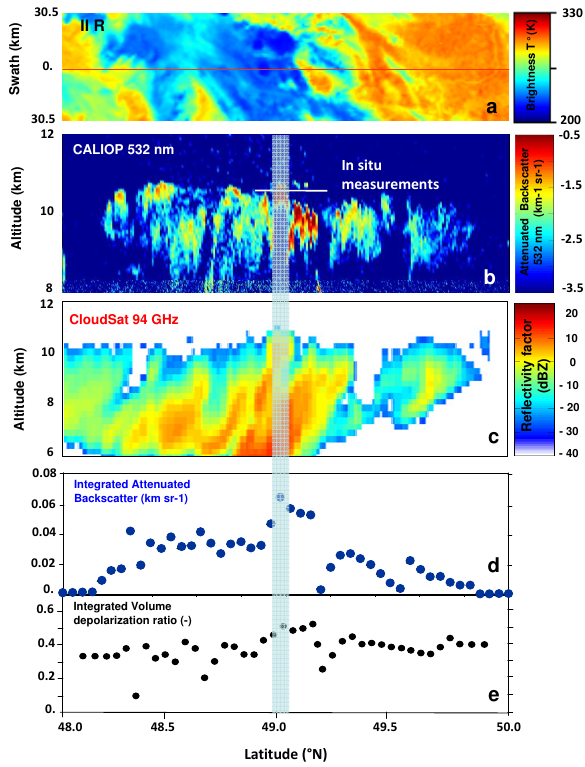
Fig. 1. (a) Imaging Infrared Radiometer (IIR); (b) vertical profile of the CALIOP 532nm attenuated backscatter coefficient; (c) vertical profile of the equivalent reflectivity factor from CloudSat; (d) inte- grated attenuated backscatter (log-scale); and (e) integrated depo- larization ratio. These observations are plotted along the CALIPSO track, i.e. between 48.5 and 49.5 ◦ N across the convective system on 26 May 2007 (12:32 UTC). The shaded area indicates the active part of the overshooting